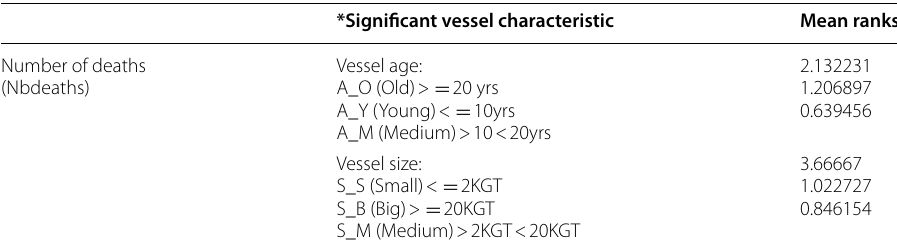
Table 3 Summary of mean ranks for significant vessel characteristics and number of deaths. Source: The